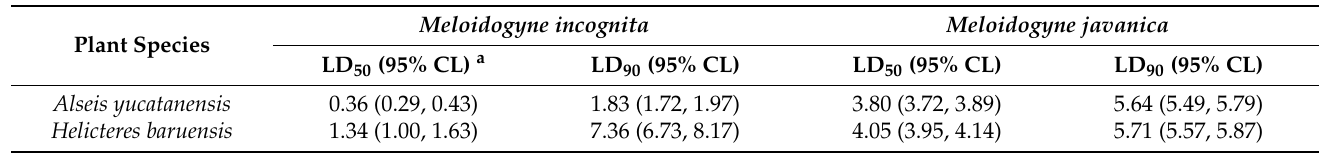
Table 3. Lethal doses (50 and 90) of the active aqueous extracts on second-stage juveniles of Meloidogyne incognita and M. javanica.